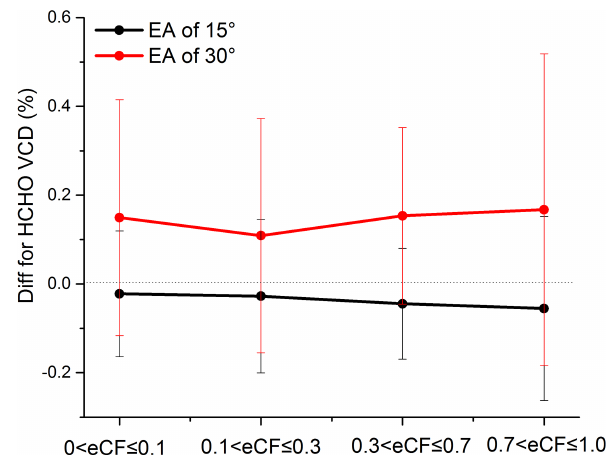
Figure 6. Relative differences in the tropospheric HCHO VCDs de- rived by geometric approximation and from profile inversion as a function of the effective cloud fractions (eCFs), as 0 < eCF ≤ 1, 0 < eCF ≤ 0 . 3, 0 . 3 < eCF ≤ 0 . 7, and 0 . 7 < eCF ≤ 1 . 0 for elevation angles of 15 and 30 ◦ . Error bars denote the standard deviations. Diff values were calculated by Eq. (5) in the